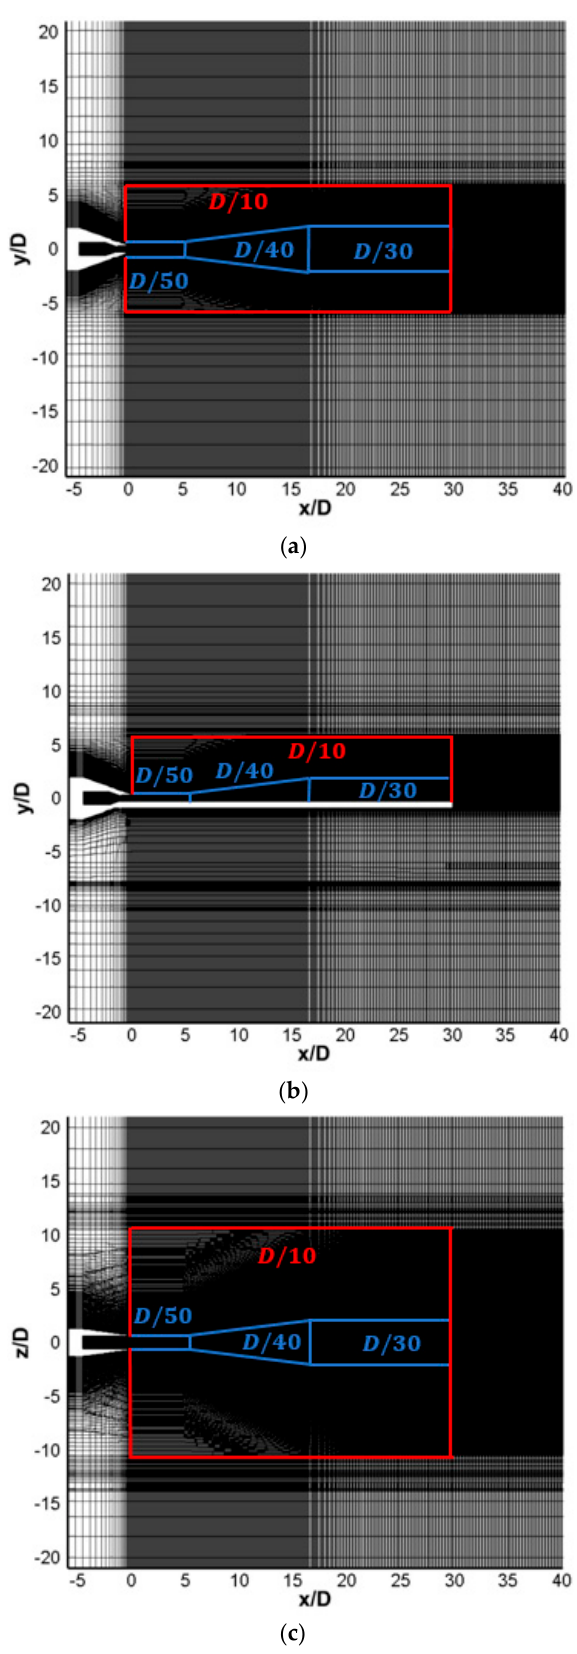
Figure 23. Computational grid and the refinement regions. ( a ) Baseline case minor plane, ( b ) Shielded case minor plane, ( c ) Both baseline and shielded cases major plane.